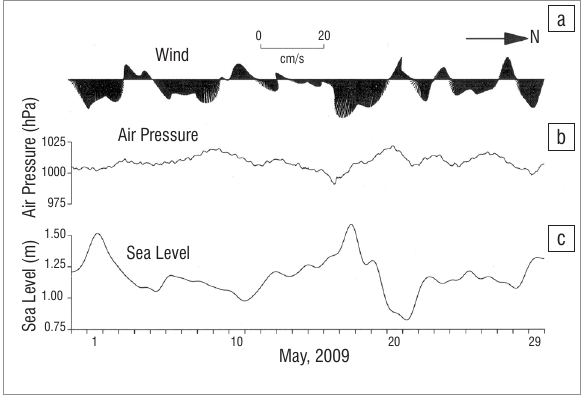
Scales for (a) and (b) are equivalent to 1 cm sea level ≡ 1 hPa air pressure. Figure 2: Time series of (a) winds (in the oceanographic sense, i.e. the vector points in the direction to which the wind is blowing), (b) air pressure and (c) sea level from Port Elizabeth. Typical sea level variations, obtained from measurements made at the Port Elizabeth harbour in 2000, are shown in Figure 3. Figure 3a shows the actual measurements, and it is clear that considerable variability exists. In particular, the longer-period sea level variations discussed above can cause substantial departures from the tidal oscillations. In Figure 3b, the longer-period variations have been removed, leaving only the tidal oscillations. As expected, the semi-diurnal M tide dominates, 2 but there is clear evidence of a diurnal oscillation, with every second tidal peak being slightly higher. Moreover, the fortnightly spring/neap variation is also apparent: neap tide variations can be less than 0.5 m whereas corresponding spring tides can be over 2 m at times.